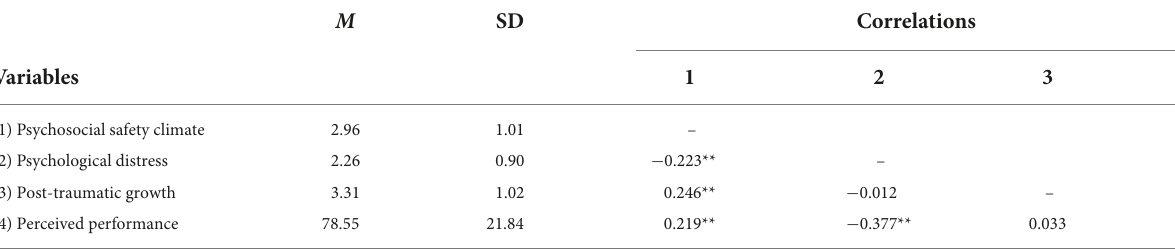
TABLE 2 Means, standard deviations, and correlations.